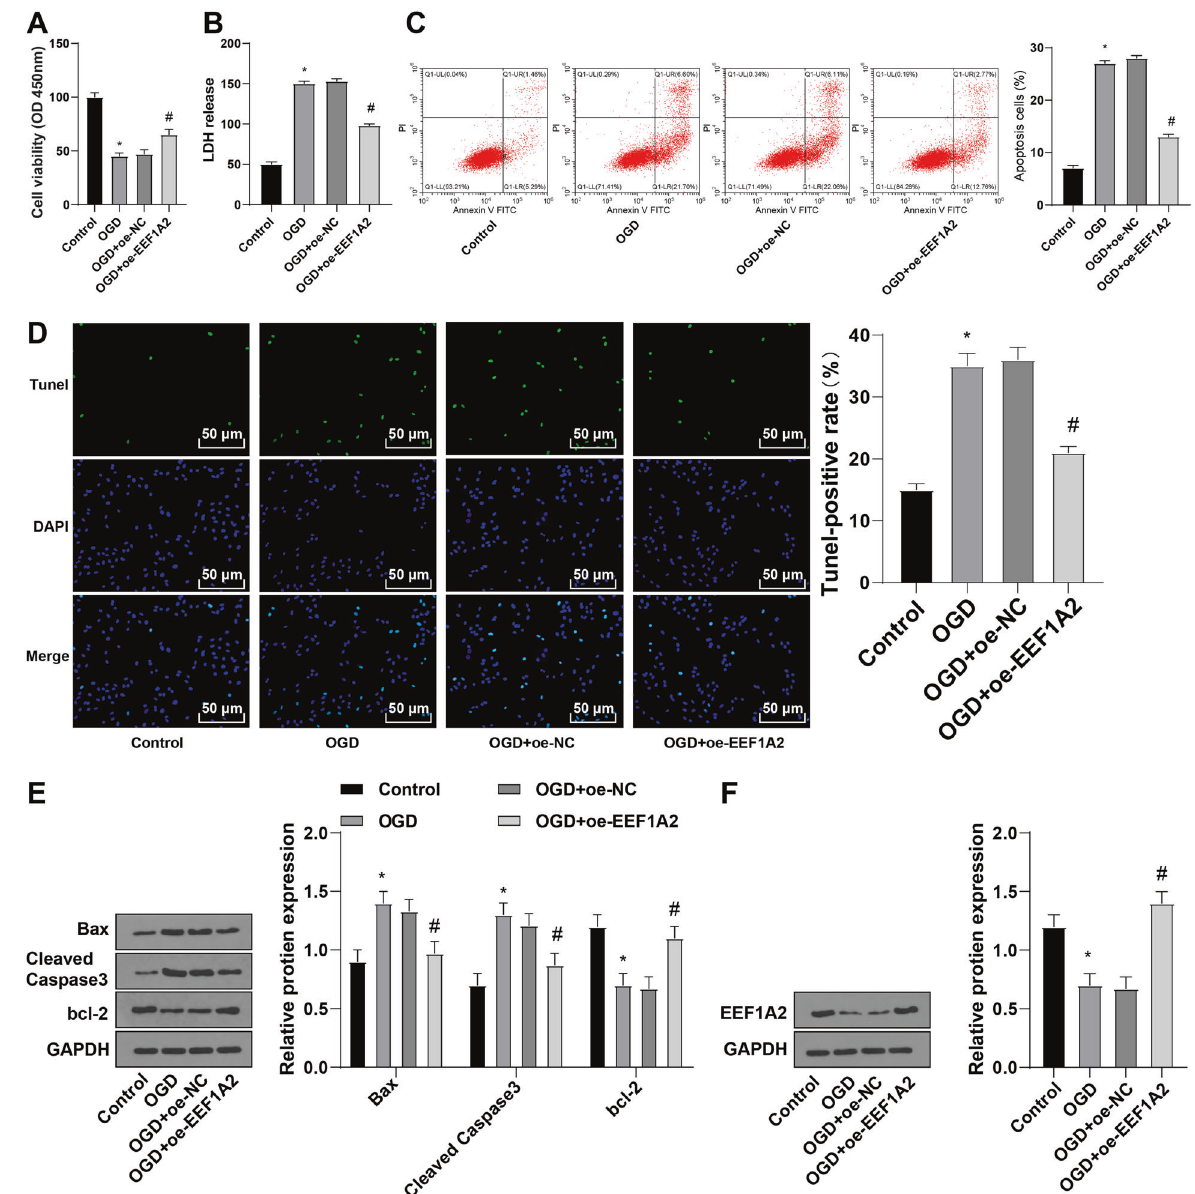
Fig. 3 EEF1A2 overexpression promoted viability and inhibited apoptosis of H/R-treated spinal cord neurons. A neuronal viability detected by CCK-8; ( B ) cell toxicity detected by LDH release assay; ( C ) neuronal apoptosis detected by fl ow cytometry; ( D ) neuronal apoptosis detected by TUNEL staining; ( E ) expressions of Bax, cleaved caspase3, and bcl-2 detected by Western blot; ( F ) expression of EEF1A2 detected by Western blot. Data were expressed as mean ± SD and analyzed using independent t test. The experiment was repeated three times.